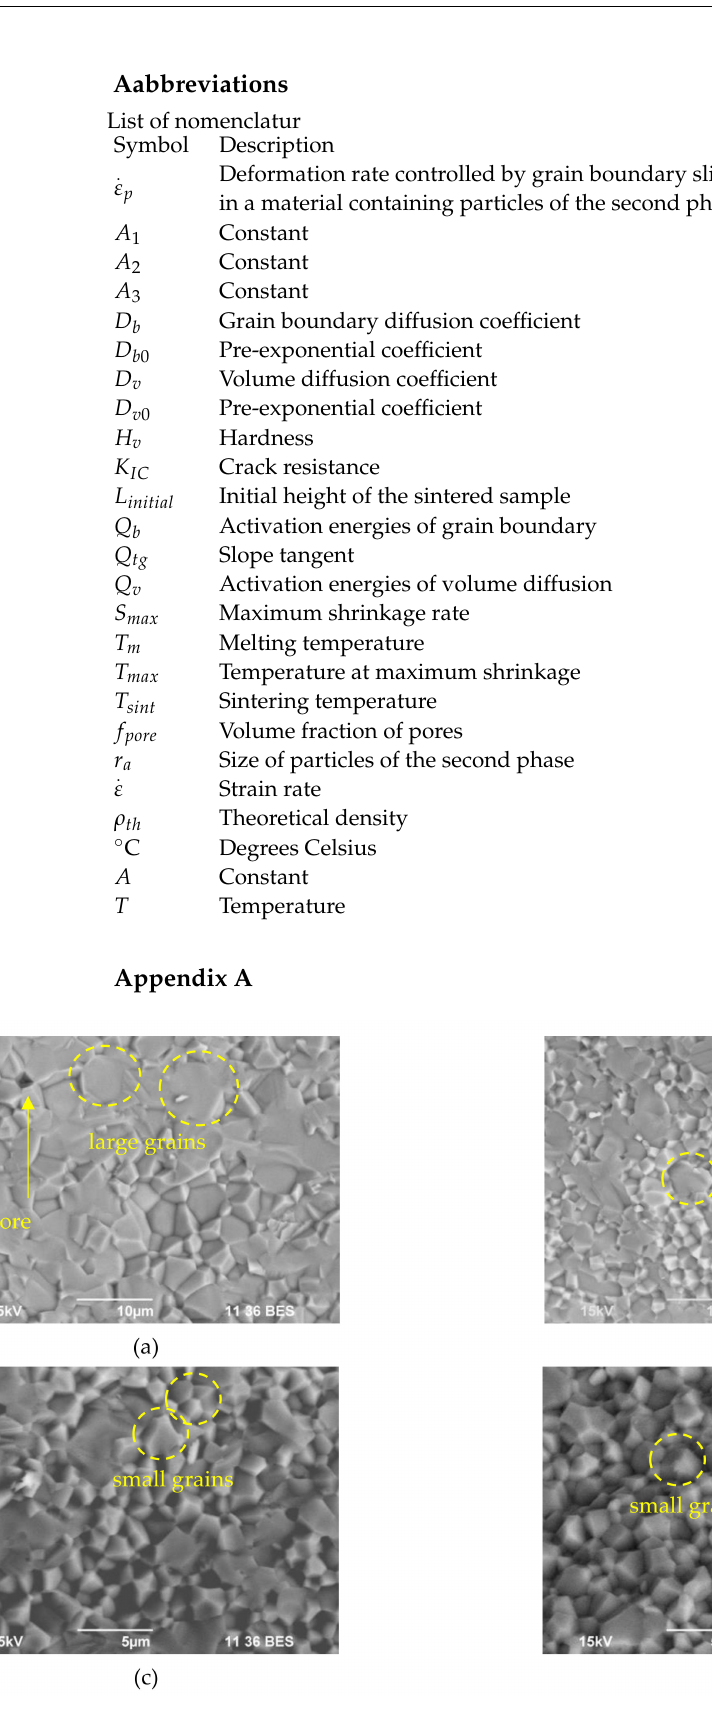
Figure A1. Fracture surfaces of α -Al 2 O 3 samples obtained at Т = 1520 ◦ C at: ( a ) 10 ◦ C/min, ( b ) 100 ◦ C/min, ( c ) 350 ◦ C/min, ( d ) 700 ◦ C/min.